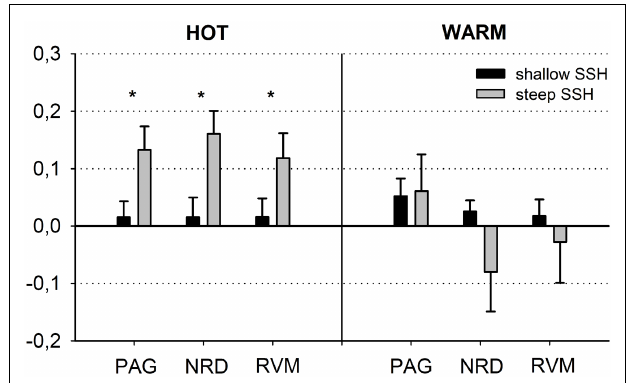
FIGURE 3 | Schematic overview of the blood oxygen level dependent (BOLD) responses in the periaqueductal gray (PAG), the nucleus Raphe dorsalis (NRD), and the rostral ventromedial medulla (RVM) (steep vs. shallow SSH forT hot andT warm conditions) .The figure depicts means ± SE of parameter estimates for the peak voxel of the structures.